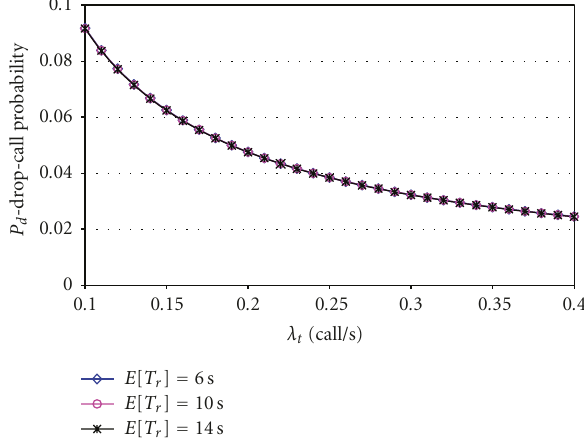
Figure 13: Drop-call probability versus λ T with several mean ring- ing